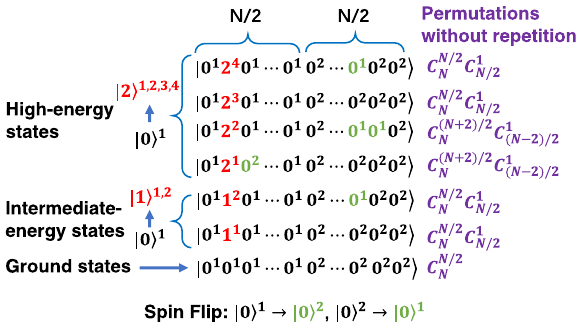
Fig. 7 Representation of the truncated Hilbert space. This space contains all the single-trimer eigenstates (see Fig. 3) in addition to the full space of states of the background spin chain, restricted to the total M = 0 sector. There are C N = 2 formed by permutation without repetition of 0 1 (cid:4)(cid:4)(cid:4) 0 1 0 2 (cid:4)(cid:4)(cid:4) 0 2